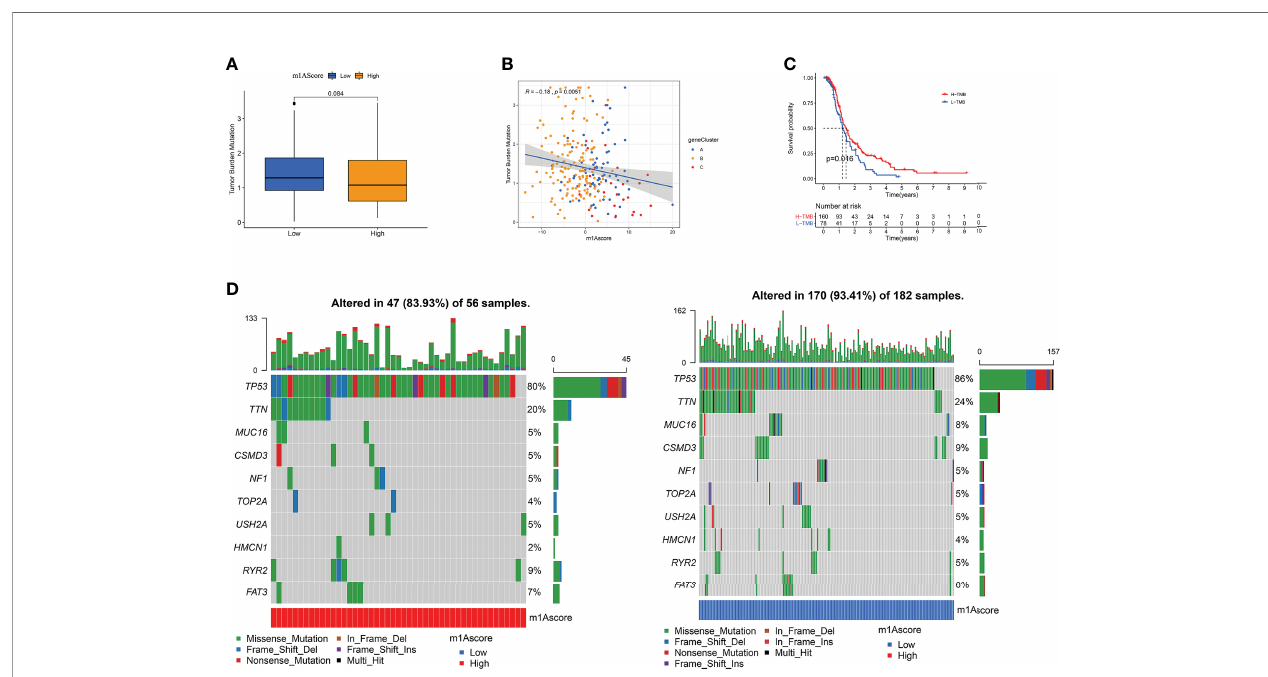
FIGURE 7 | The Correlation between the m1Ascore and somatic variants. (A) TMB difference in the high and low m1Ascore subgroups. (B) Scatterplots depicting the positive correlation between m1Ascores and tumor mutation load. (C) Kaplan-Meier curves for high and low TMB groups of the TCGA-OV patient. (D) The single-nucleotide variant was constructed using high m1Ascores on the left (red) and low m1Ascores on the right (blue). Individual patients are represented in each